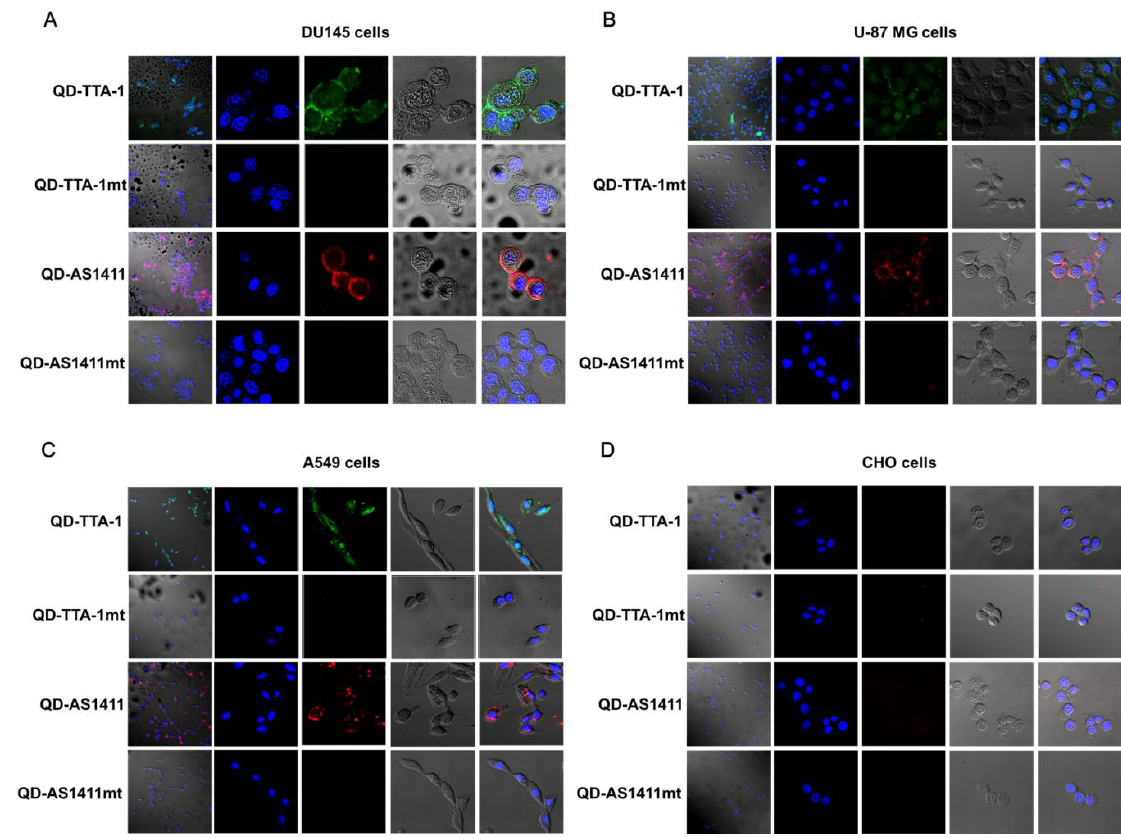
Figure 3. Confocal microscope images of cells incubated with QD-aptamer conjugates. ( A ) DU145; ( B ) U-87 MG; ( C ) A549; and ( D ) CHO cells. The first column shows a magnification of 200X and columns 2 through 5 show a magnification of 800X. Columns 1 and 5: merged fluorescence image of DAPI and bright field and each QD-aptamer conjugate; column 2: DAPI (blue: 420–480 nm); column 3: QD-aptamer conjugates for imaging of tenascin-C (green: 560–615 nm) and imaging of nucleolin (red: 647–690 nm); column 4: bright field.